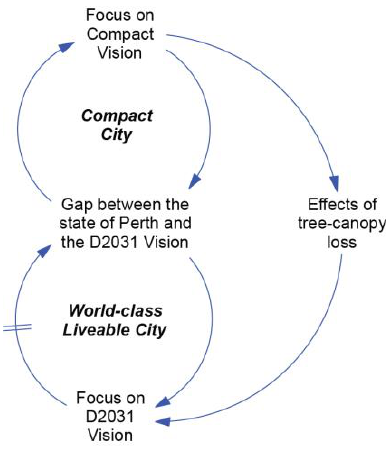
Figure 9. Tunnel Vision.